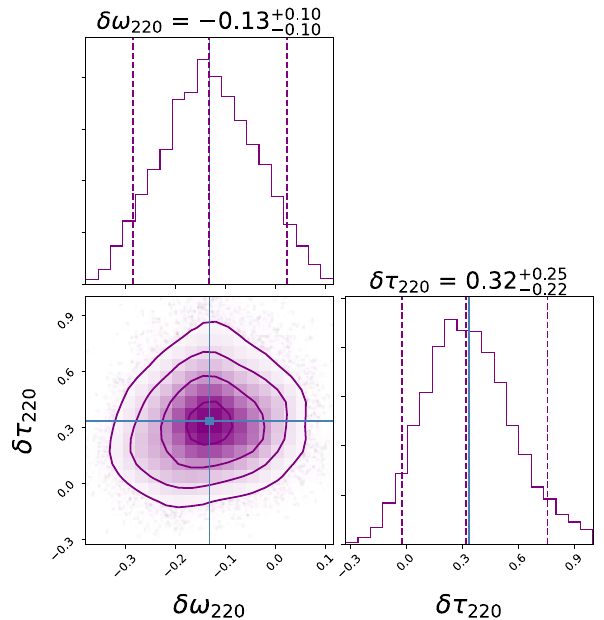
Fig. 6 As a proof-of-concept, we perform a rudimentary parameter estimation of the GR deviations using PyRing for event GW150914 (GWdatasampledat4096Hz).Wenarrowpriorstoreducecomputation cost.With Corner ,weplotthe2Dposteriorsand1Dhistogramson( δω , δτ ), where ( 0 , 0 ) is the GR-predicted value. Dashed lines and contours demarcate the 90% credible region; the blue line indicates the mean Table 5 To correspond to the search for parametric deviations in GR, we structure our results for ω = R e { ω } and the damping time τ